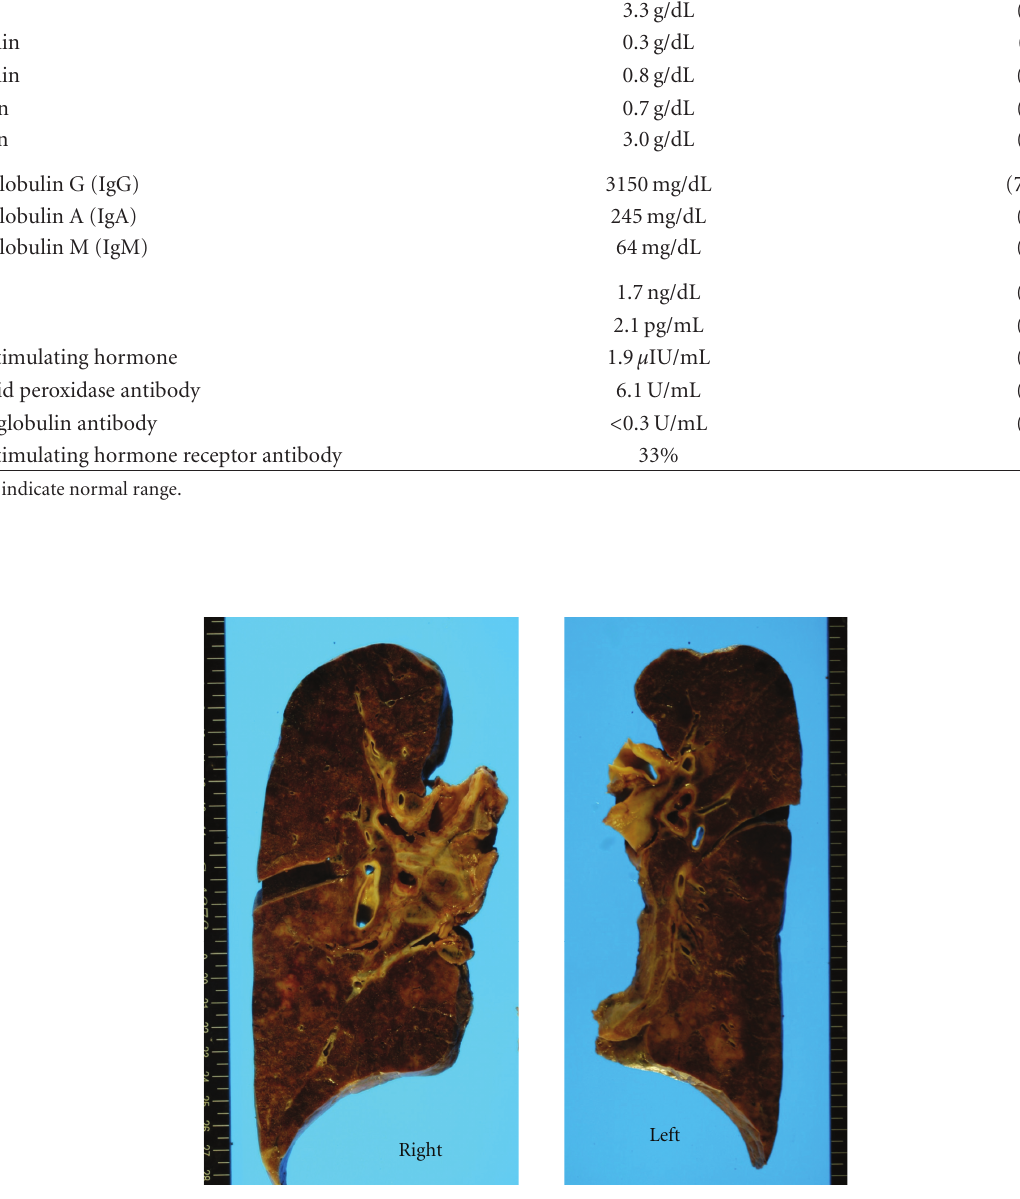
Figure 2: Lung cut surfaces. The left lung weighed 655 g and the right lung 890 g. Both lungs show severe congestion and hemorrhage. No tumorous lesions are grossly